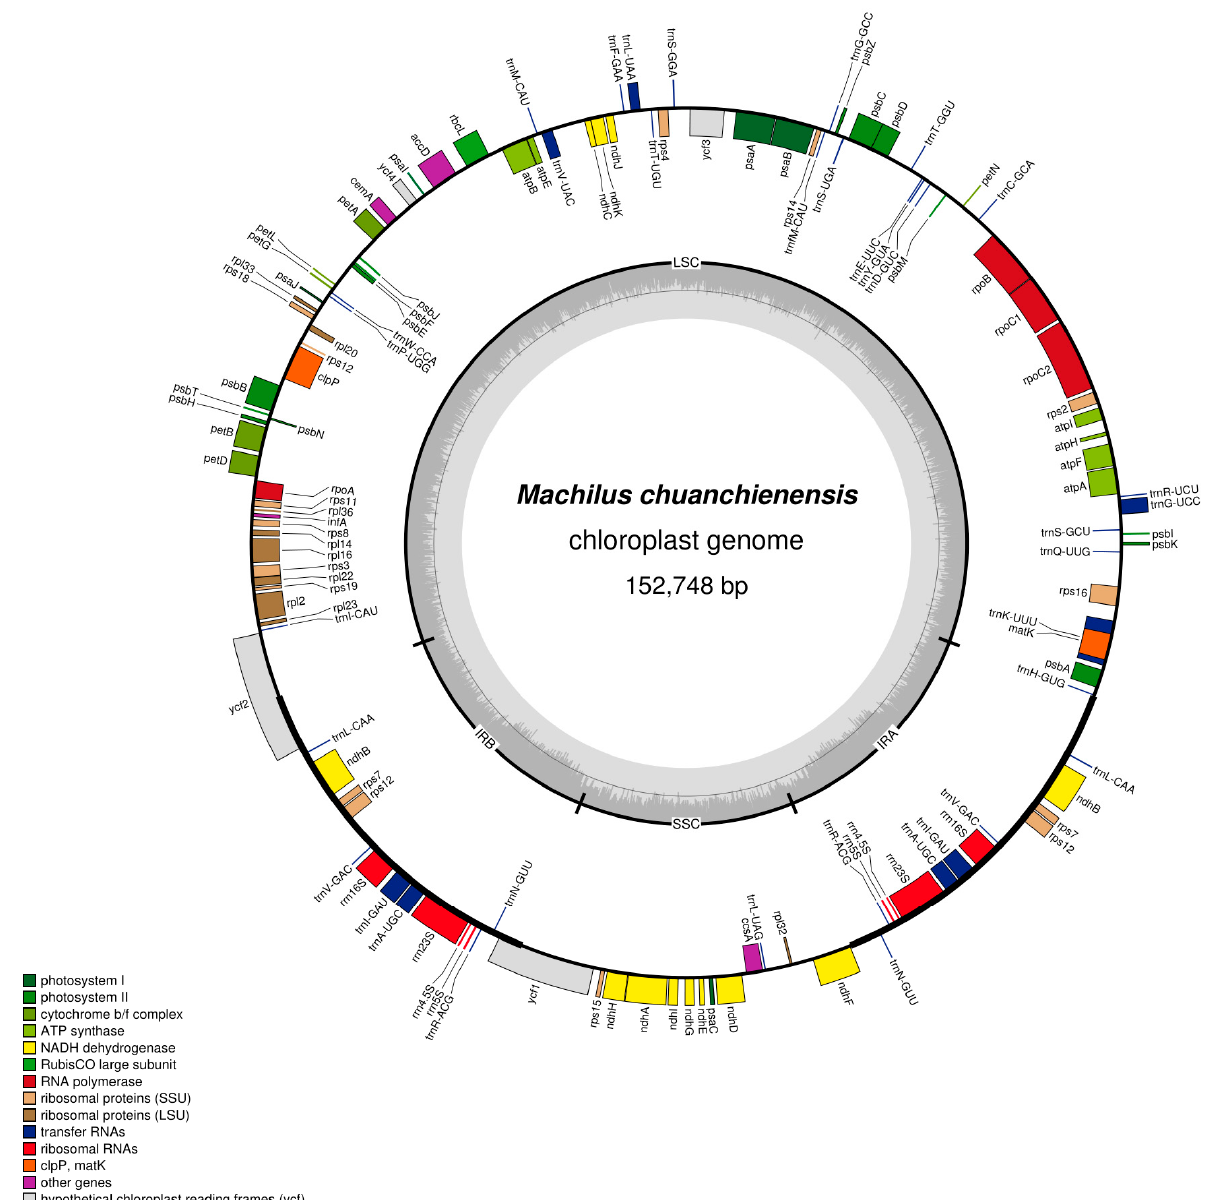
Figure 1. Chloroplast genome map of M. chuanchienensis . Genes on the outside of the main circle are transcribed clockwise, while genes on the inside are transcribed counterclockwise. The Organellar Genome Draw (OGDraw) online software was used to draw this map. Genes with different functions are represented by different colors. The gray portion of the inner circle indicates the GC content of the chloroplast genome.